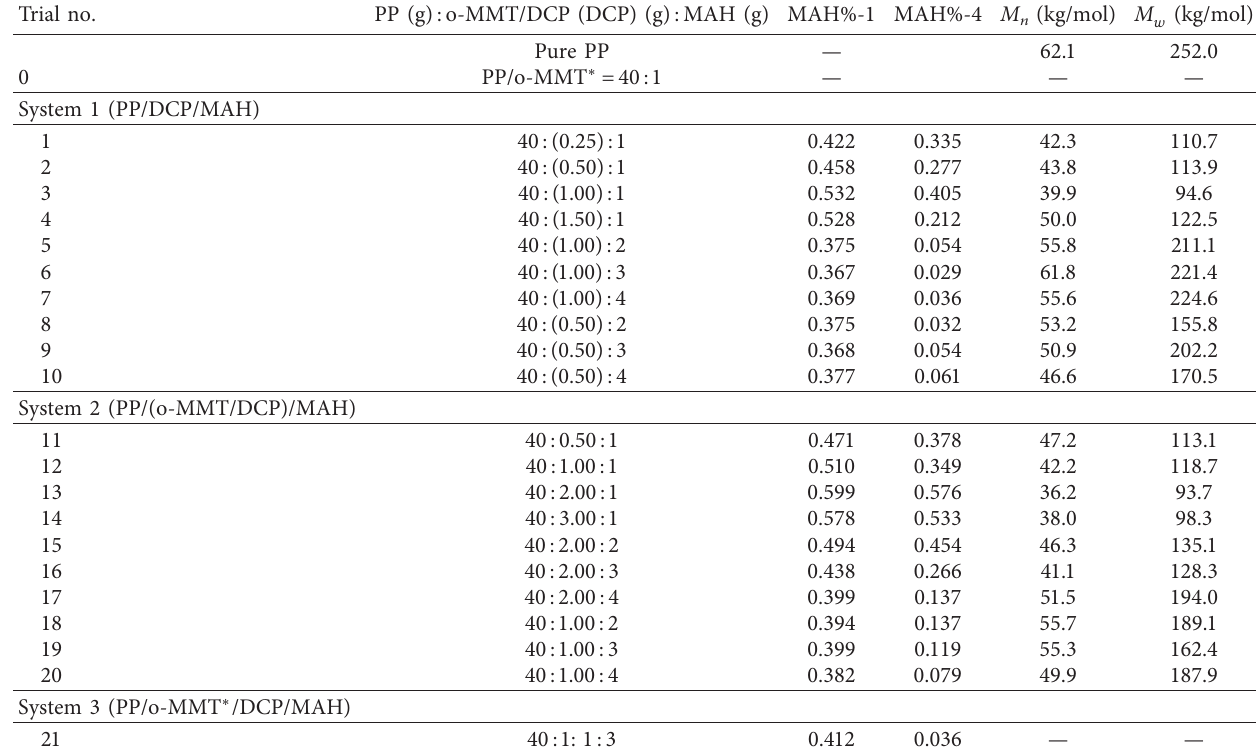
Table 1: Compositions of all the trials carried out in this work and selected characteristics.